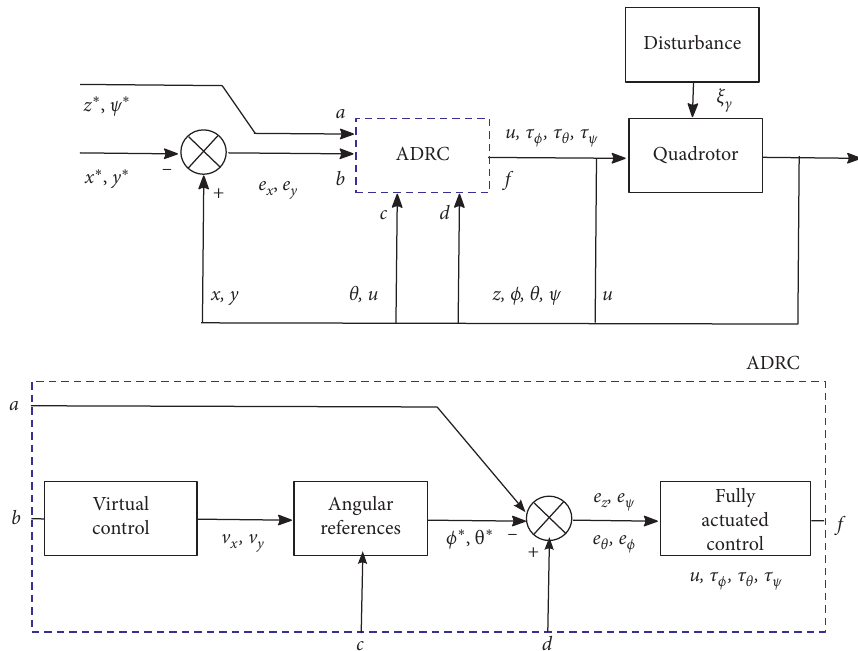
Figure 5: Main robust motion control scheme for a disturbed aerial quadrotor